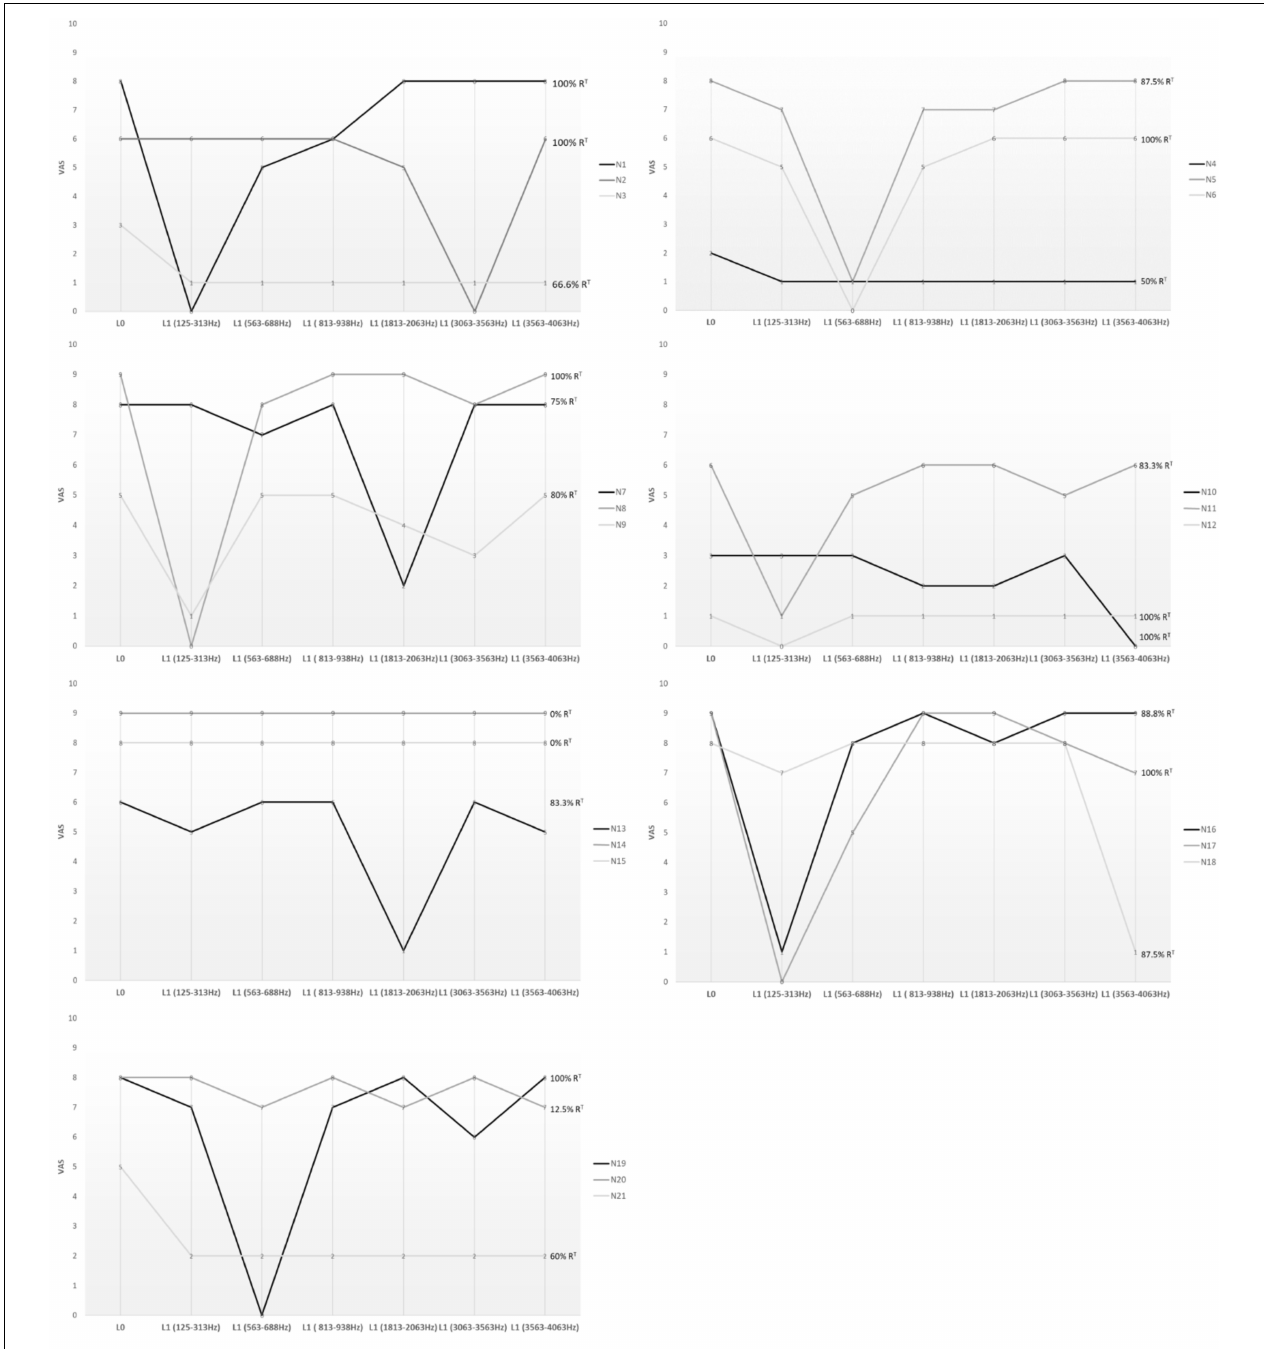
FIGURE 2 | The Visual Analog Scale (VAS) was used to assess tinnitus modification. Patients were asked to rate the perceived loudness of their tinnitus on a numeric scale, from 0 (inaudible) to 10 (loud like never before), during short-term single-channel stimulation. The figure shows the cochlear regions involved in each patient. Only the frequency bands corresponding to the best-performer channels are depicted in the figure, not the entire cochlear tonotopy. L 0 , basal loudness of tinnitus; L 1 , loudness of tinnitus at 10 s single-channel stimulation; R T , greatest percentage of tinnitus reduction.